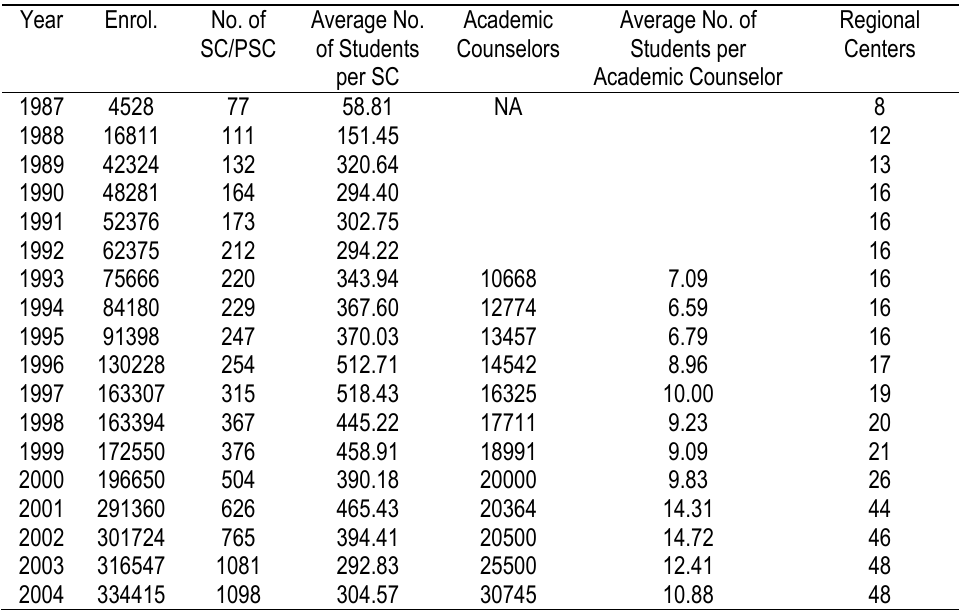
Table 2. Growth Trend of Support Service Network of